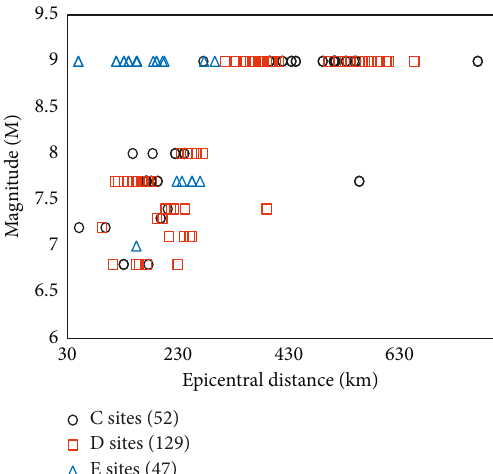
Figure 7: Distribution of the identified long-period ground